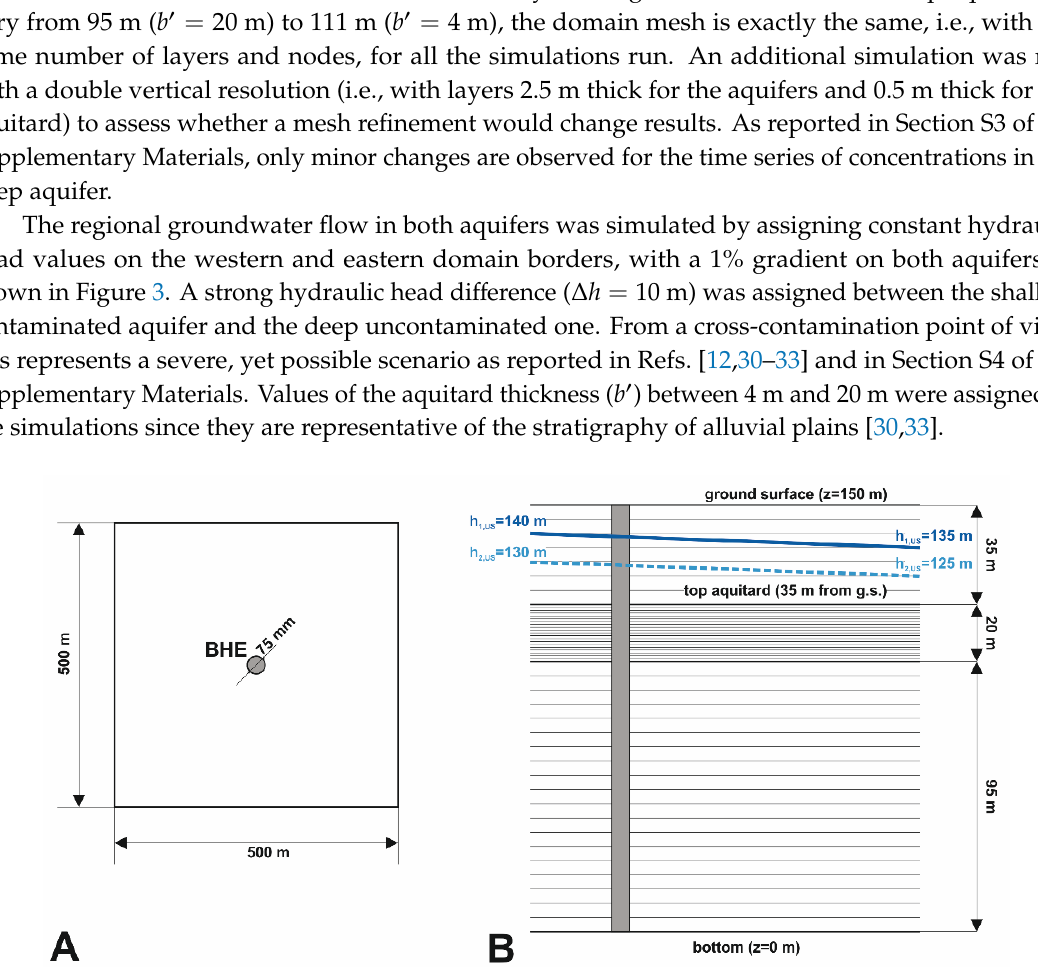
Figure 3. Model domain geometry: ( A ) Plan view of the model (borehole heat exchanger (BHE) not to scale) and ( B ) cross-section with the layers and hydraulic head distribution in the shallow aquifer (dark blue continuous line) and in the deep aquifer (dashed light blue line).